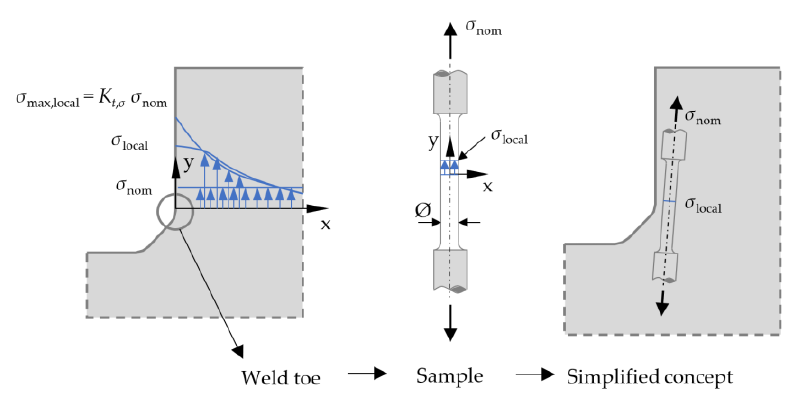
Figure 4. The concept of similarity for the “ notch strain ” approach.